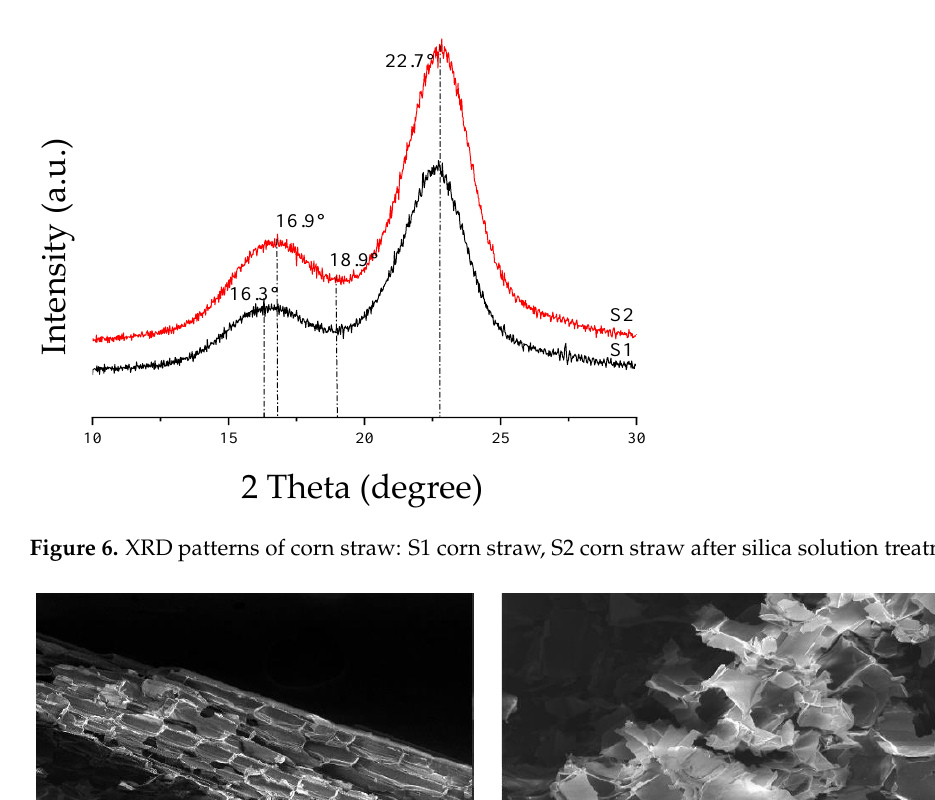
Figure 7. Microstructure of corn straw treated with siliceous solution: ( a ) vertical section of corn straw, ( b ) vertical section of corn straw core.